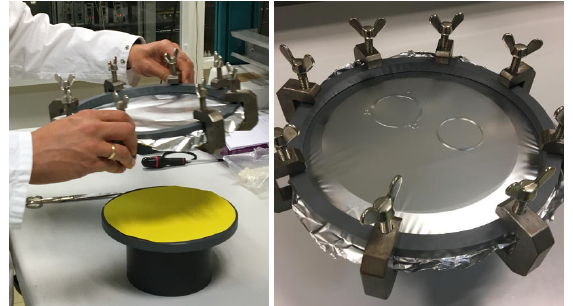
Fig. 2. Stretching process of an Al foil